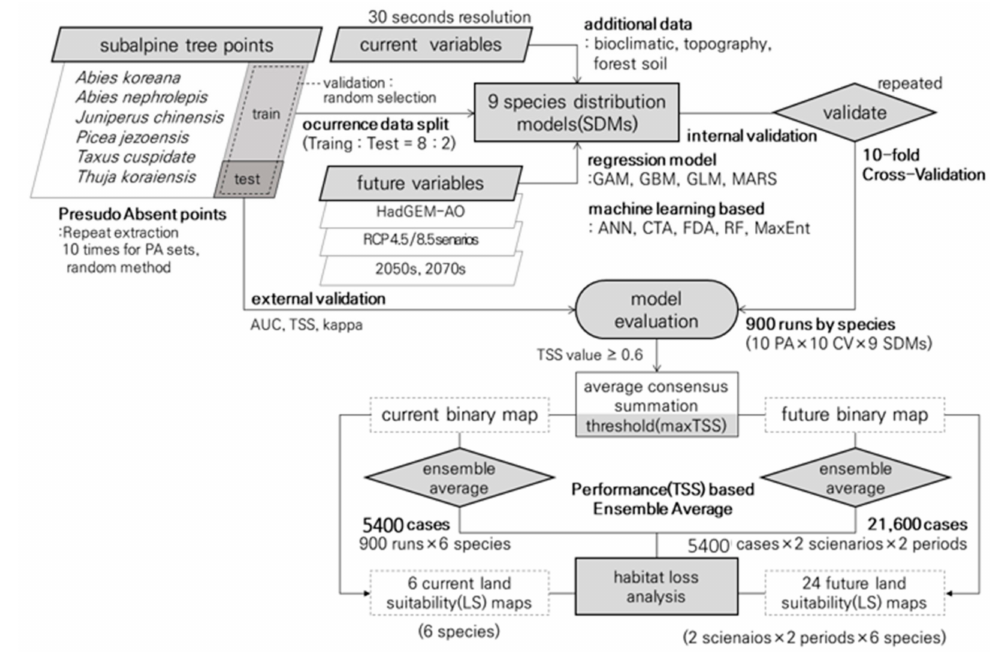
Figure 2. Schematic representation of the ensemble species distribution modeling